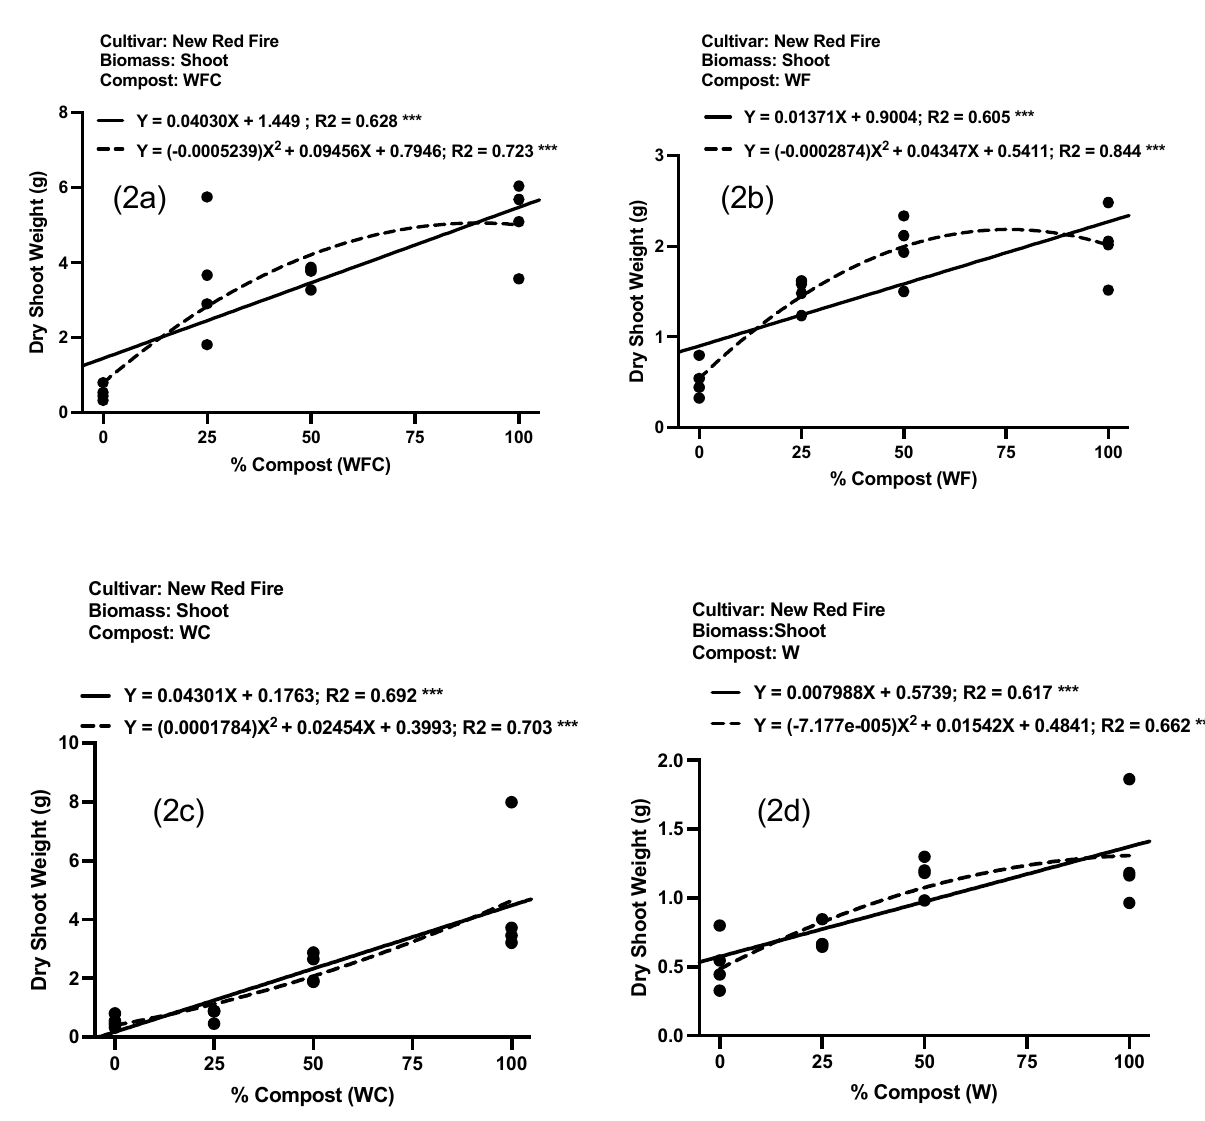
Figure 2. Effect of the percent of compost in growing media on the dry shoot biomass of cv. New Red Fire: ( 2a ) Compost WFC; ( 2b ) Compost WF; ( 2c ) Compost WC; and ( 2d ) Compost. *** significant at p < 0.001.